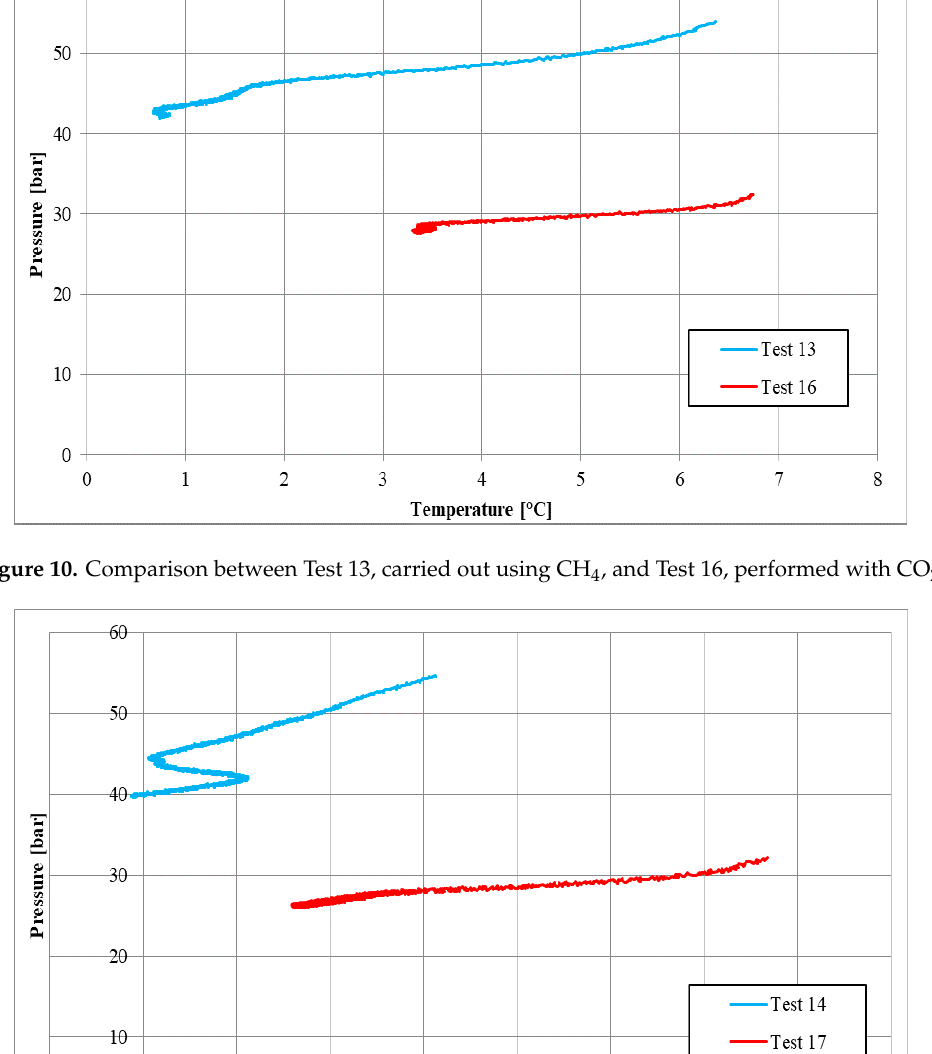
Figure 11. Comparison between Test 14, carried out using CH 4 , and Test 17, performed with CO 2.